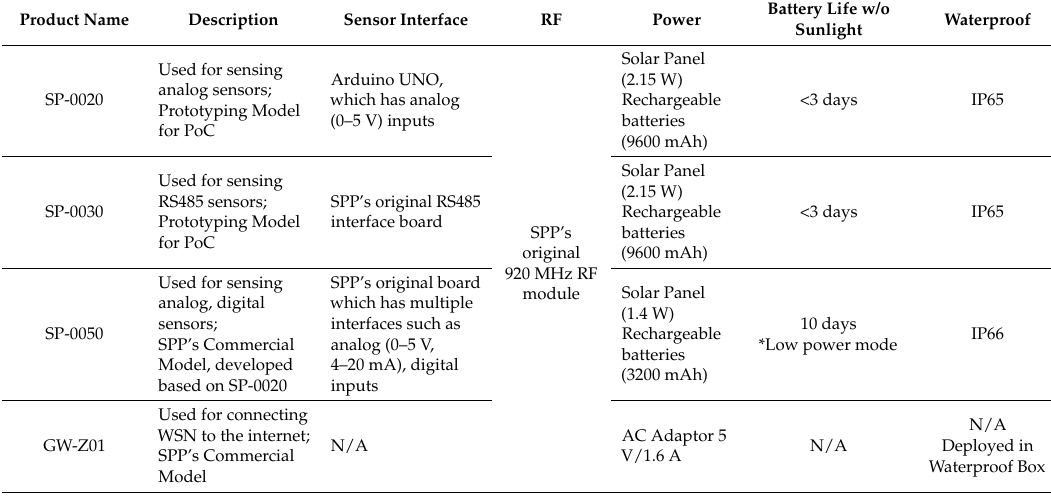
Table 1. WSN Devices.